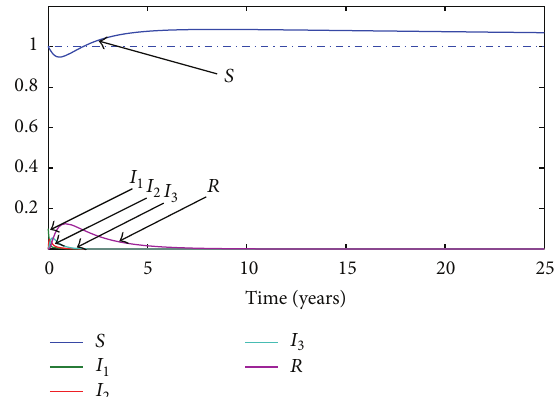
Figure 2: Dynamic of the subpopulations for 𝑅 0 = 0.5 . The dotted line represents the predicted disease-free value of the susceptible